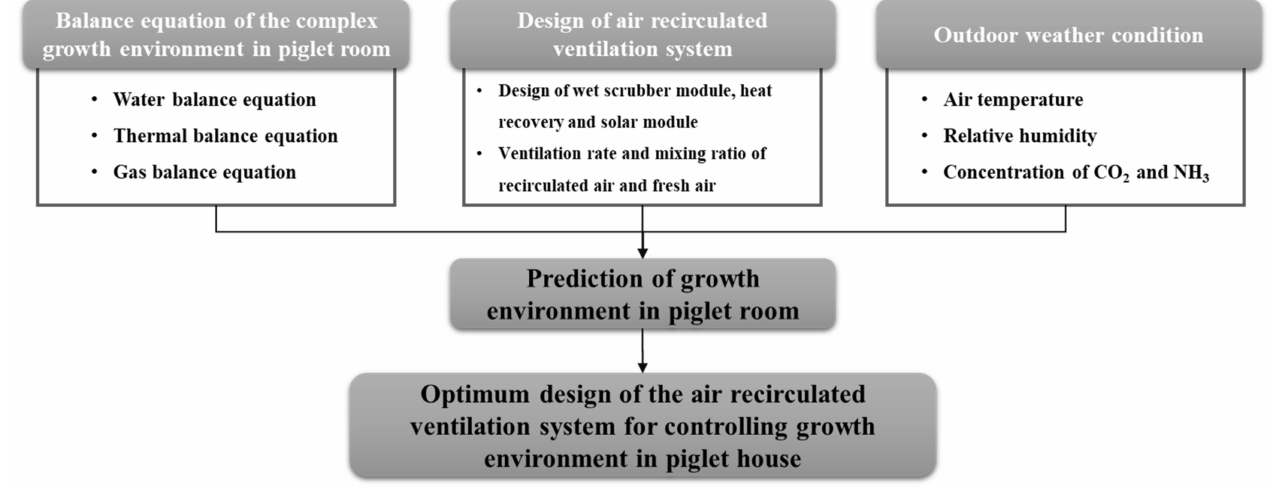
Figure 2. Flow chart for a numerical model of air recirculated ventilation